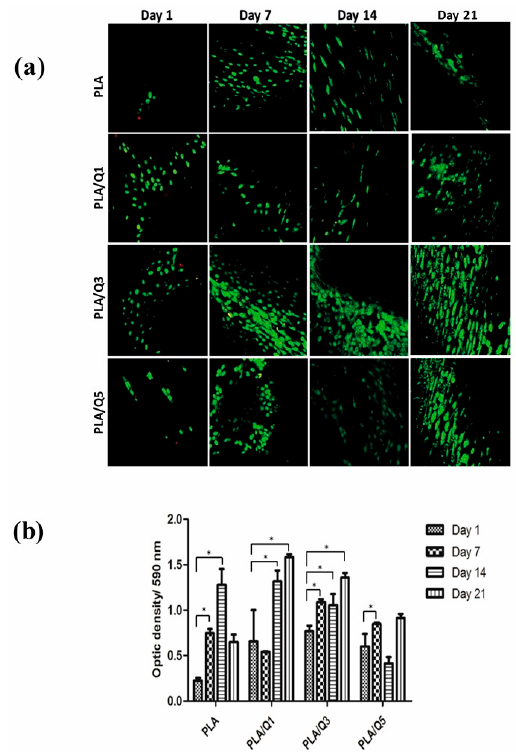
Figure 7. Viability and proliferation of osteoblasts on the PLA and PLA/chitosan composites surfaces. ( a ) Fluorescence of osteoblasts on PLA and composites. Viable cells are visualized in green and death cells are in red. Images were taken at 20×; ( b ) MTT metabolic activity of the osteoblasts on PLA and composites.